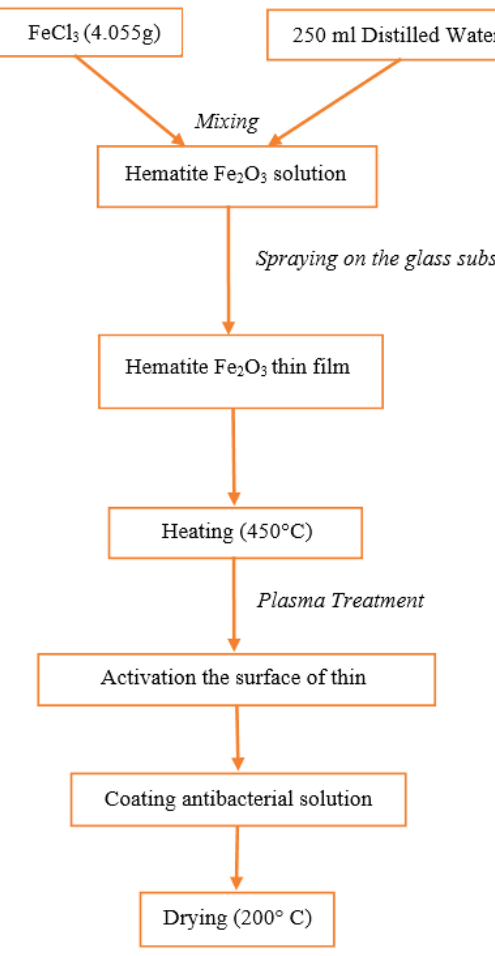
Figure 1. Flow chart of research